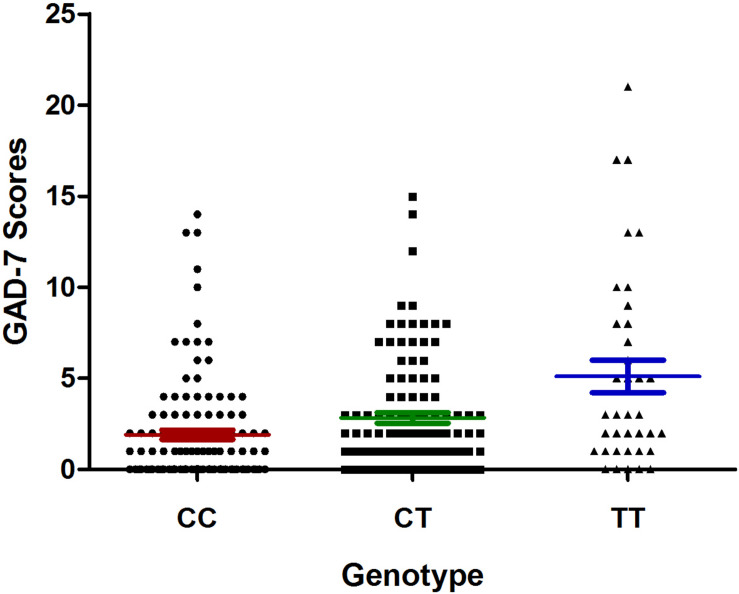
Association of apelin receptor (APLNR) rs2282623 polymorphism with generalized anxiety disorder 7 (GAD-7) scores in coronary heart disease (CHD) patients with comorbid anxiety. The filled circle means CC genotype carriers, the filled square means CT genotype carriers and the filled triangle means the TT genotype carriers. The red lines mean the mean ± SD of GAD-7 score of CC group, the green lines mean the mean ± SD of GAD-7 score of the CT group, and the blue lines mean the mean ± SD of the GAD-7 score of the TT group.